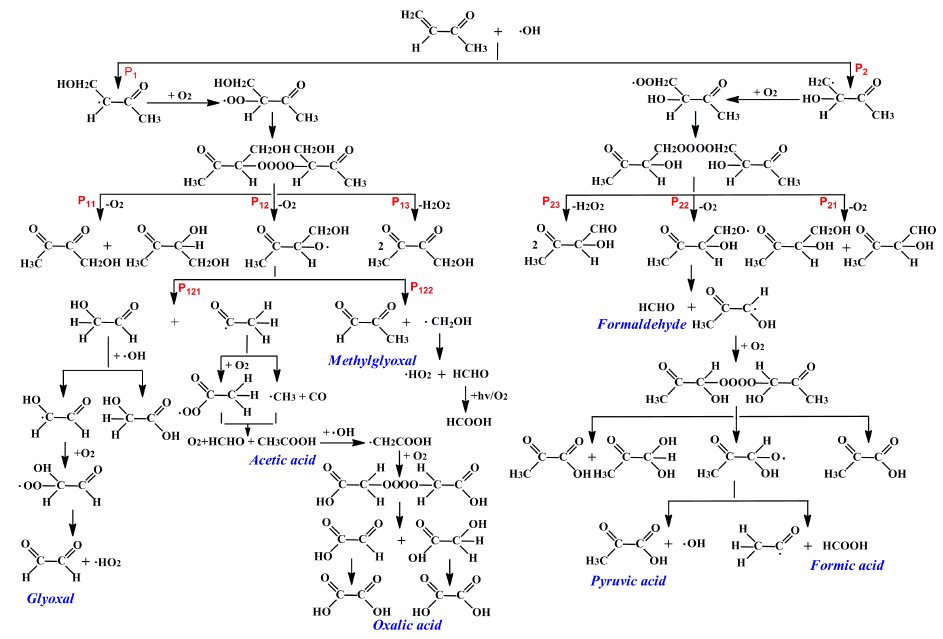
Fig. 5. Scheme for the tentatively proposed reaction pathways leading to the observed products from the MVK–OH